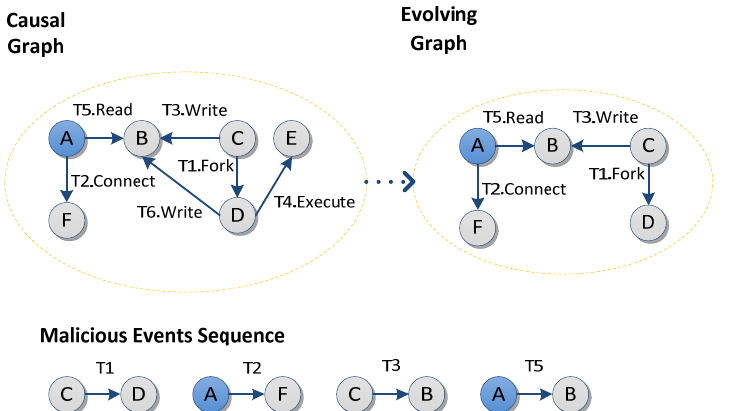
Figure 4. The 6 ‐ evolving graph. An example of generating an evolving graph ( right ) from a causal graph ( left ), back tracing from the current point T6 to all events at time point T1. One malicious entity A is contained, while the others such as {B, C, D, E, F} ( left ) and {B, C, D, F} ( right ) are non ‐ malicious entities.